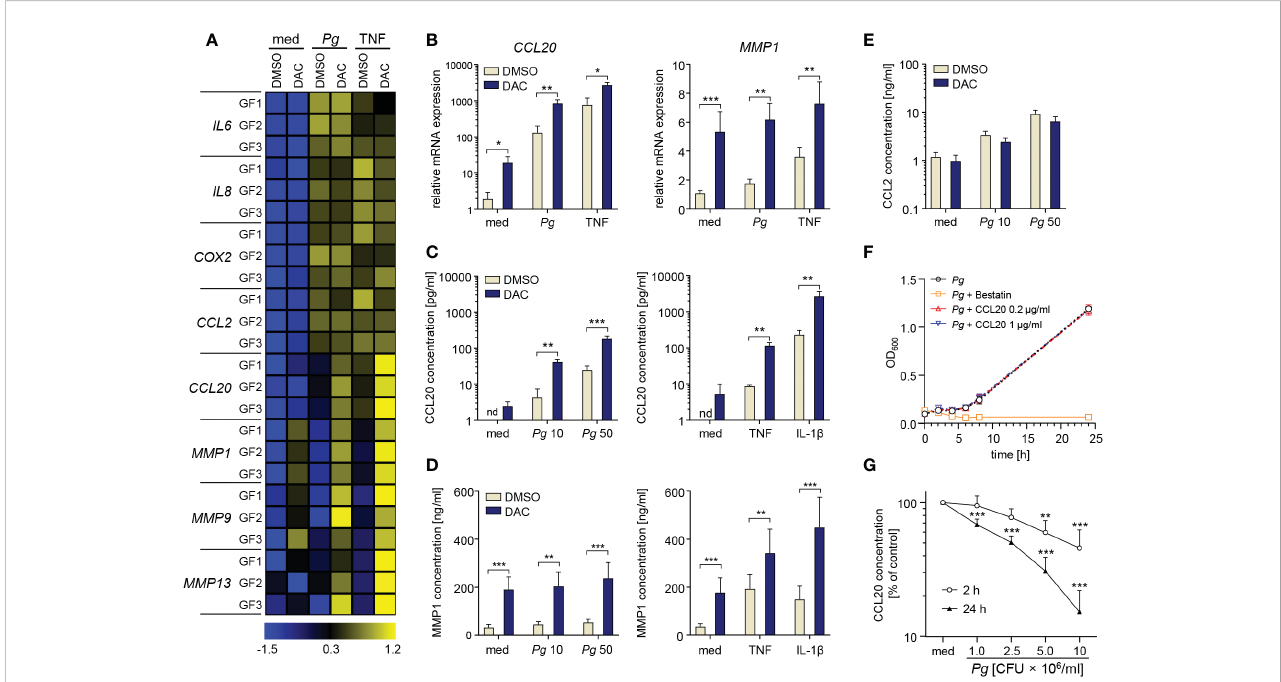
FIGURE 2 DAC promotes production of CCL20 and MMPs by GFs. (A, B) GFs treated with DMSO or DAC for 12 days were left unstimulated in medium (med), or were infected with P. gingivalis ( Pg , MOI 20), or stimulated with TNF (10 ng/ml) for 4 h. (A) qPCR analysis of mRNA expression of in fl ammatory mediators in GFs from individual donors (GF1-GF3) shown on a heatmap as row Z-scores calculated from D Ct values relative to a housekeeping gene ( RPLP0 ). (B) Relative mRNA levels of CCL20 and MMP1 (n=5). (C-E) DMSO- or DAC-treated GFs were infected with P. gingivalis (MOI 10 or 50) for 1 h followed by washing and culture for another 23 h in fresh medium containing antibiotics or were stimulated with TNF or IL-1 b (both 10 ng/ml) for 24 h. Production of (C) CCL20, (D) MMP1 and (E) CCL2 is shown as mean concentration +SEM (n=4-8). (F) Growth curve of P. gingivalis cultured anaerobically in the presence of recombinant human CCL20 (0.2 and 1 m g/ml) or bestatin (5 mg/ml) (positive control) (n=3). (G) Degradation rate of CCL20 by P. gingivalis at 10 6 , 2.5×10 6 , 5×10 6 , and 10 7 CFU/ml after 2 h and 24 h of incubation (n=4). nd, not detectable; *P < 0.05, **P < 0.01, ***P < 0.001.